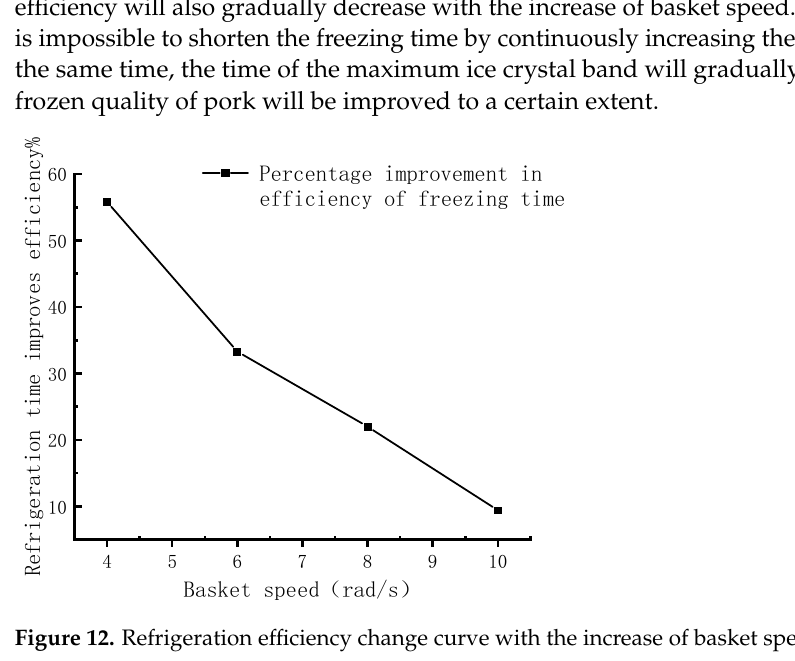
Figure 12. Refrigeration efficiency change curve with the increase of basket speed.